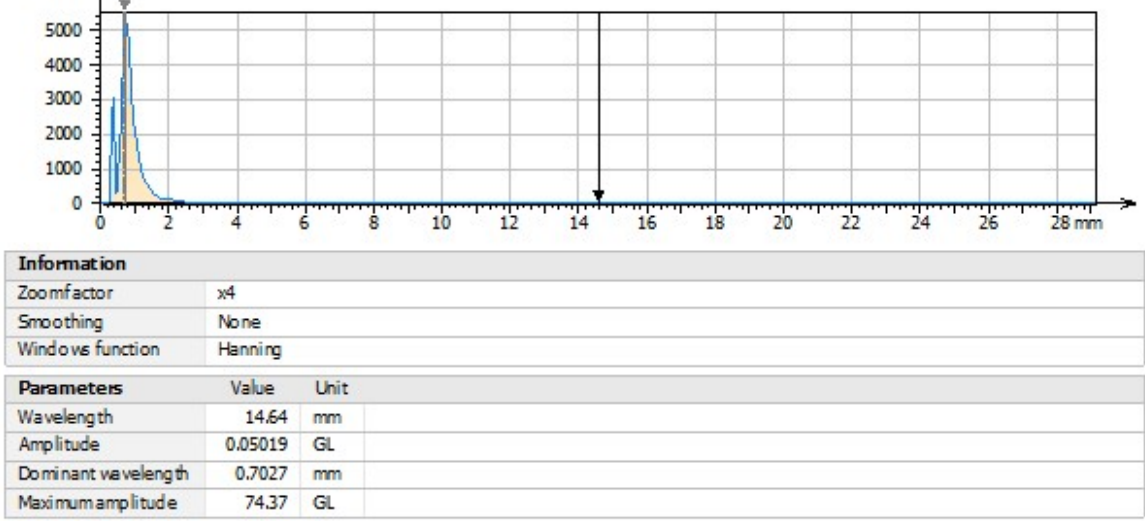
Figure 15. Average power spectrum density of scaffolds in presence of pork bone.